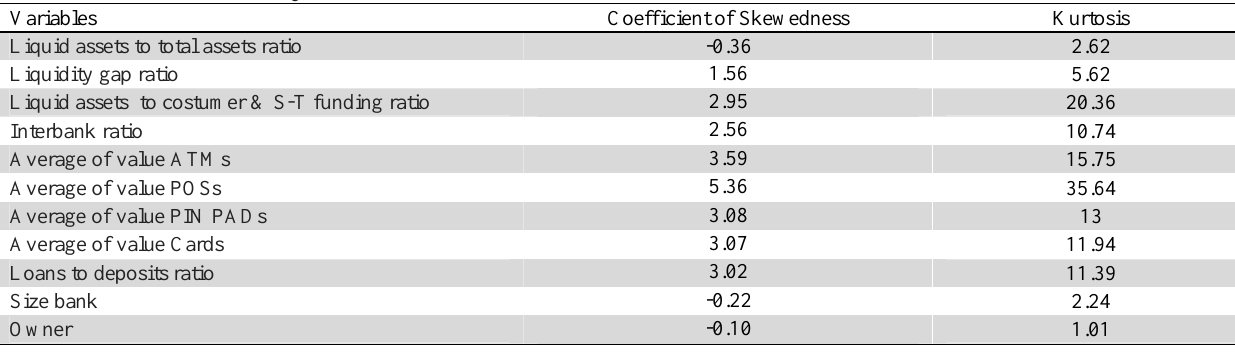
Evaluation for normality variables